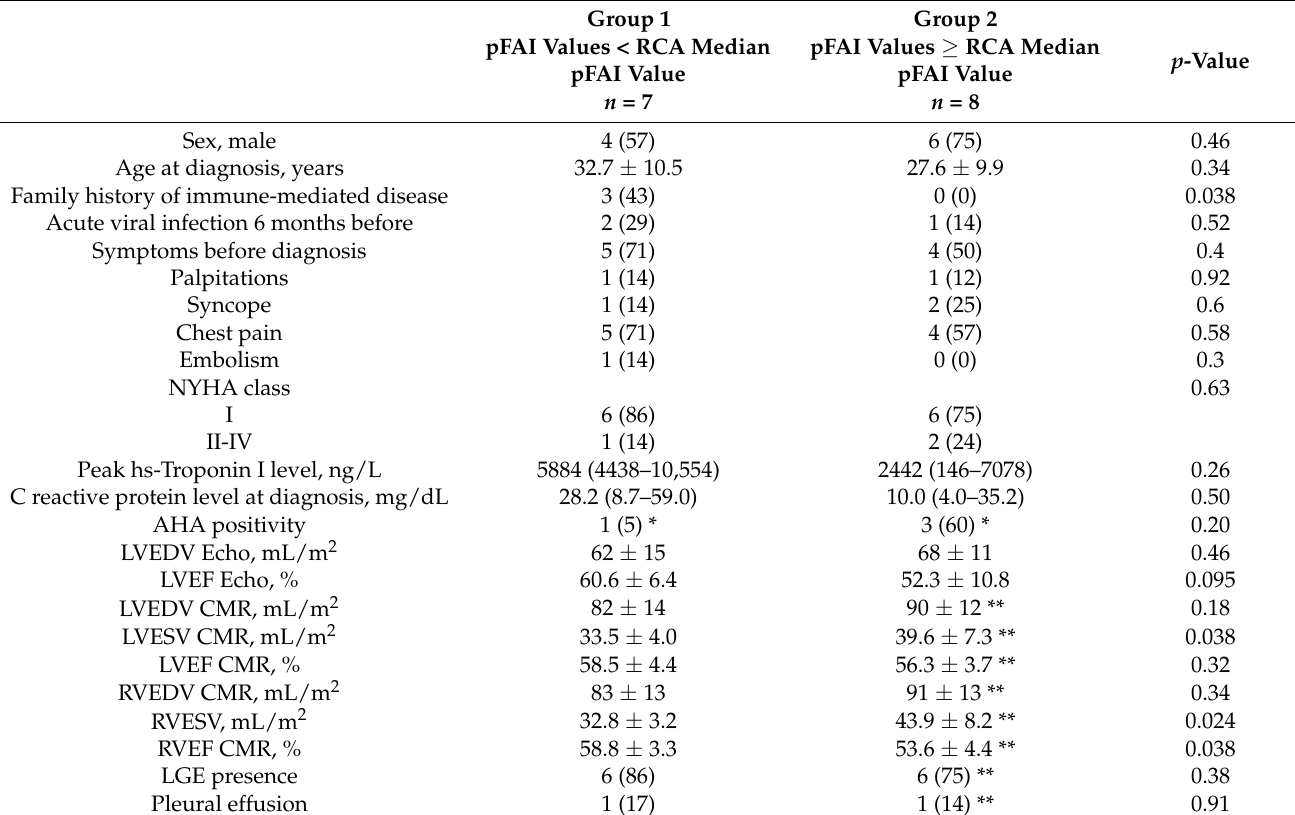
Table 3. Demographic, clinical, and imaging characteristics according to RCA median pFAI